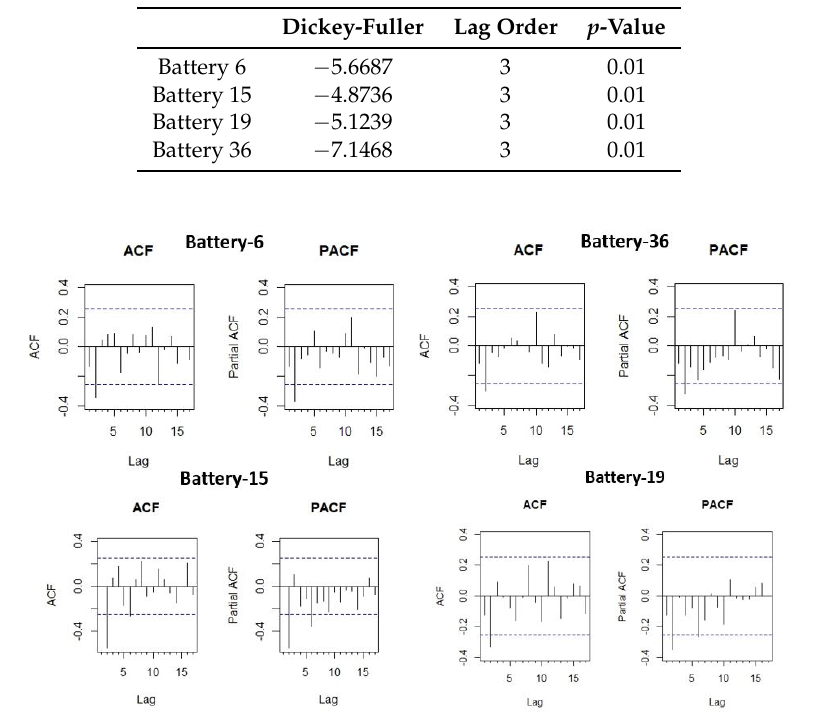
Table 3. The augmented Dickey-Fuller.